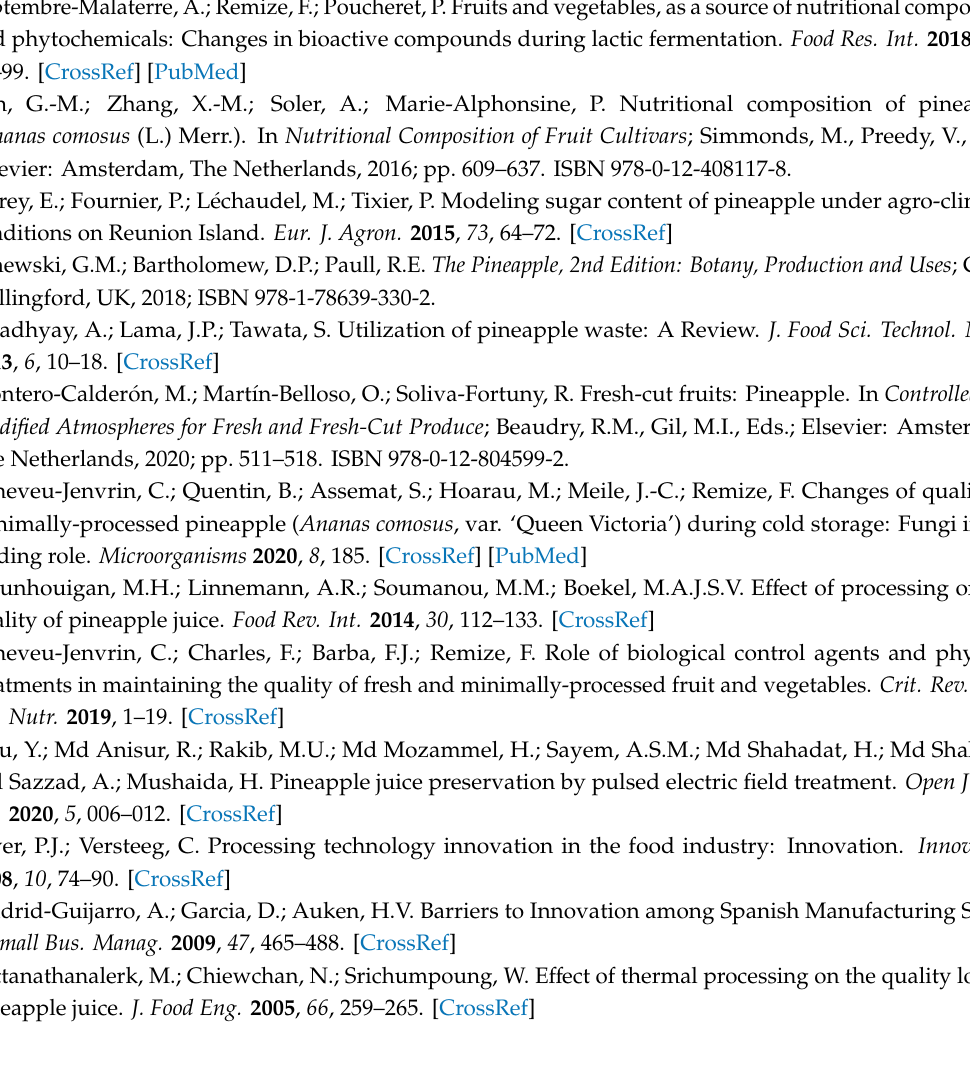
Table S1: Mean values of quality parameters of pineapple juice before and after pasteurization at 60 ◦ C, Table S2: Mean values of quality parameters of pineapple juice before and after pasteurization at 70 ◦ C, Table S3: Mean values of quality parameters of pineapple juice before and after pasteurization at 80 ◦ C, Table S4: Mean values of quality parameters of pineapple juice before and after pasteurization at 86 ◦